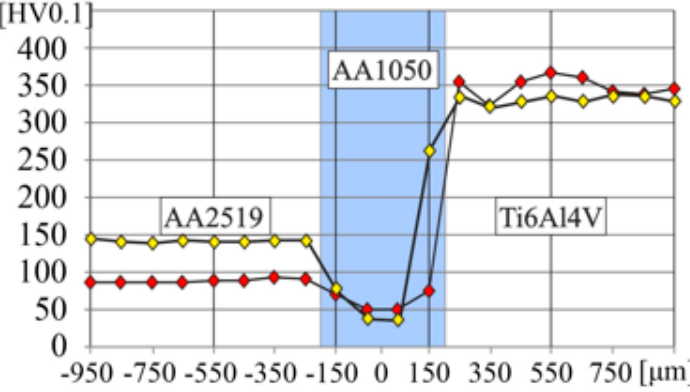
Figure 12. The results of microhardness measured in AA2519–Ti6Al4V laminate with interlayer of AA1050.